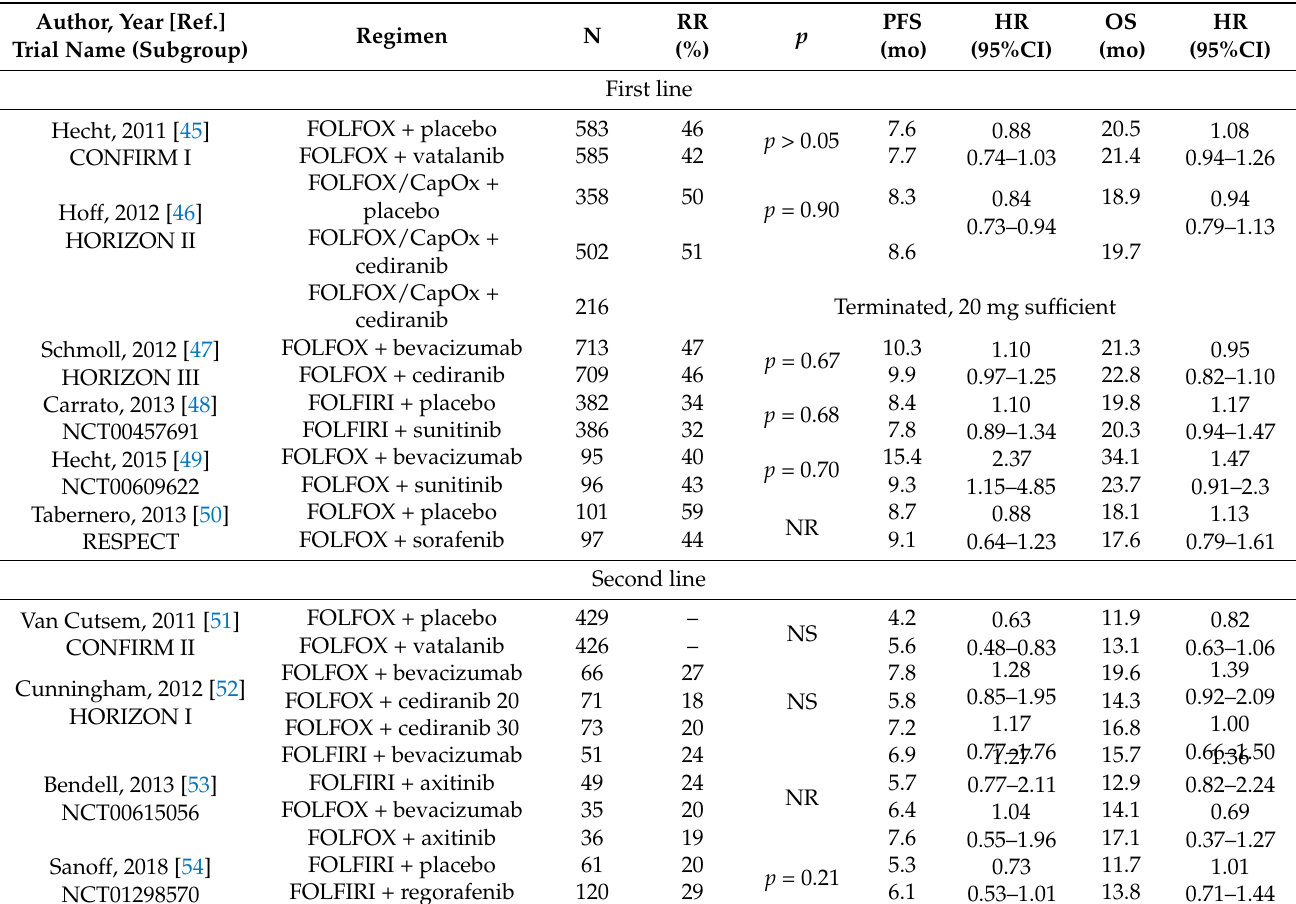
Table 4. Principal randomized trials comparing chemotherapy with or without tyrosine kinase inhibitor (TKI) as first or second line therapy in unselected patients with mCRC.